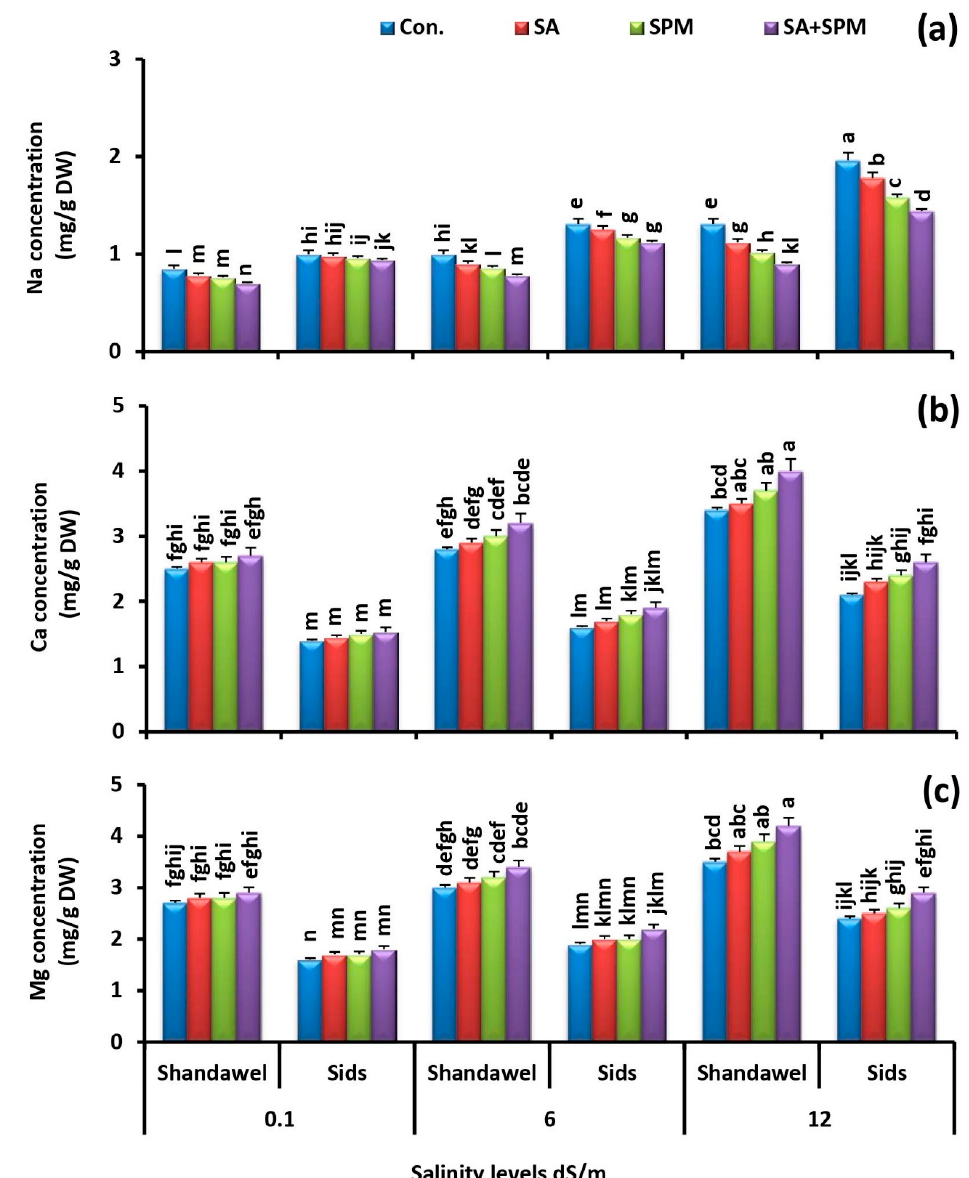
Figure 6. Influence of salicylic acid (SA; 100 mgL − 1 ) and/or spermine (SPM; 30 mgL − 1 ) on the concentration of ( a ) sodium, ( b ) calcium, and ( c ) magnesium in grains of two wheat cultivars (Shandawel 1 and Sids 14) grown under 0.1, 6, and 12 dS m − 1 salinity levels. Data are mean of four replicates (n = 4). Different letters indicate significant differences at ( p < 0.05) level, according to Duncan’s test.